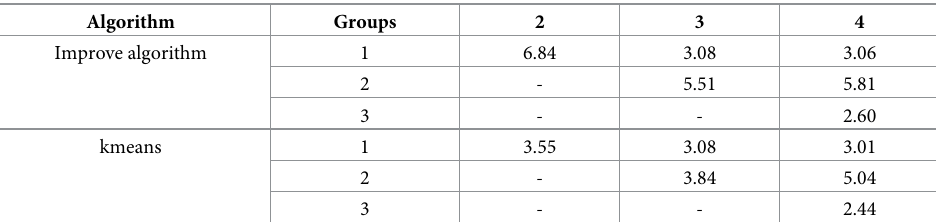
Table 4. Distance between